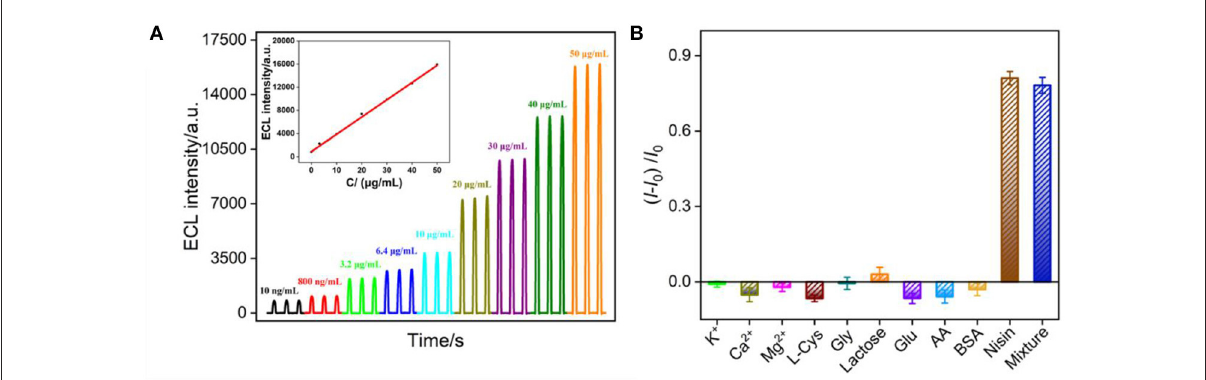
FIGURE6 (A) ECL response of VMSF/ITO electrode obtained using Ru(bpy) 32 + @liposome probe in presence of different concentrations of nisin. Inset is the calibration curve for the detection of nisin. The voltage of PMT is 650V. (B) The increased ECL intensity ratio obtained using Ru(bpy) 32 + @liposome probe in presence of different substances. The concentration of K + , Ca 2 + , Mg 2 + , L-Cys and Gly lactose, Glu, and AA is 40 µ g/ml, BSA is 1%. The concentration of nisin is 10 µ g/ml. I and I 0 represent the ECL signal in absence or presence of one or mixed substance,